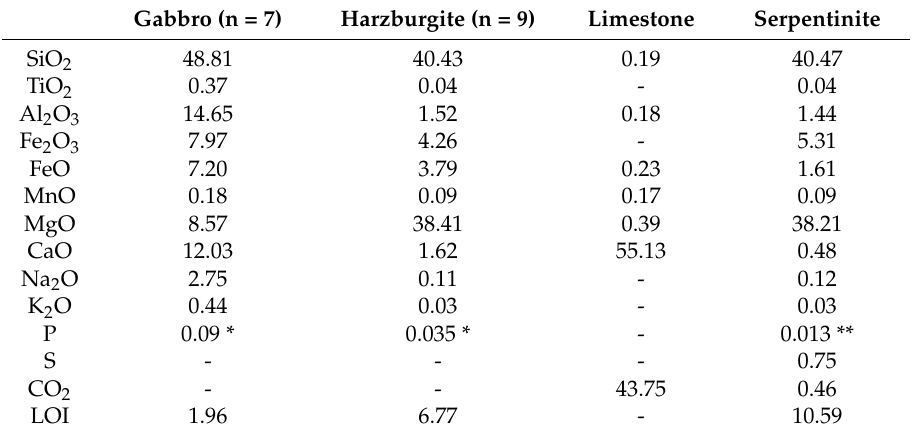
Table 2. Chemical compositions of rocks involved in the thermodynamic